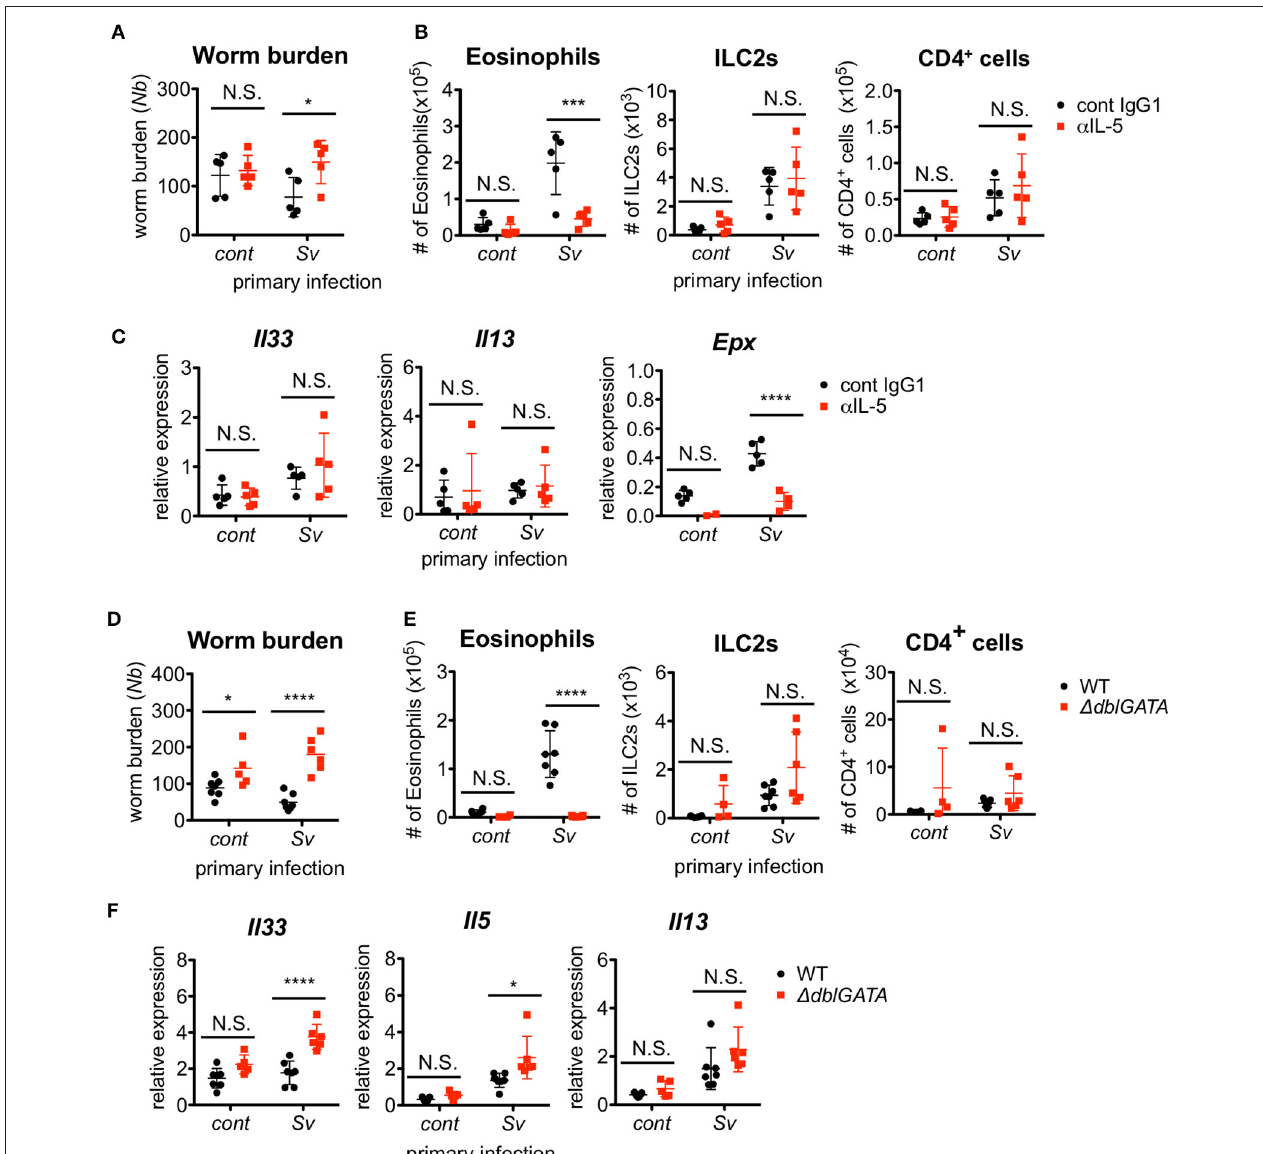
FIGURE 3 | Eosinophils are essential for resistance against Nippostrongylus brasiliensis . (A–C) S. venezuelensis -infected (Sv) or uninfected (cont) mice ( n = 5) were treated with anti-IL-5 Ab (TRFK5, α IL-5) or control Ab (cont IgG1) at day 0 and day 2 post-infection with N. brasiliensis (Nb). (A) The numbers of worms in the intestine were counted at day 5 after N. brasiliensis infection. (B) ILC2s, eosinophils, and CD4 + cells among the BALF cells were analyzed by flow cytometry (SP6800). Cell populations were defined as follows: ILC2s, FSC lo SSC lo CD45 + CD4 − Lin(CD3, CD8, CD19, NK1.1, IgE, siglec F, Gr-1) − Sca-1 + ST2 + ; Eosinophils, CD45 + CD11c lo CD3 − B220 − CCR3 + ; and CD4 + cells, FSC lo SSC lo CD45 + CD4 + . (C) Il33 , Il13 , and Epx mRNA expression levels in the lungs were examined. Data are representative of two independent experiments that had similar results. (D–F) S. venezuelensis -infected or uninfected (cont) mice (WT, n = 7; 1 dblGATA , n = 5–6) were infected with N. brasiliensis . (D) The numbers of worms in the intestine were counted at day 5 after N. brasiliensis infection. (E) Eosinophils, ILC2s, and CD4 + cells among the BALF cells were analyzed as in (B) . (F) Il33 , Il5 , and Il13 mRNA expression levels in the lungs were examined. Data are representative of two independent experiments that had similar